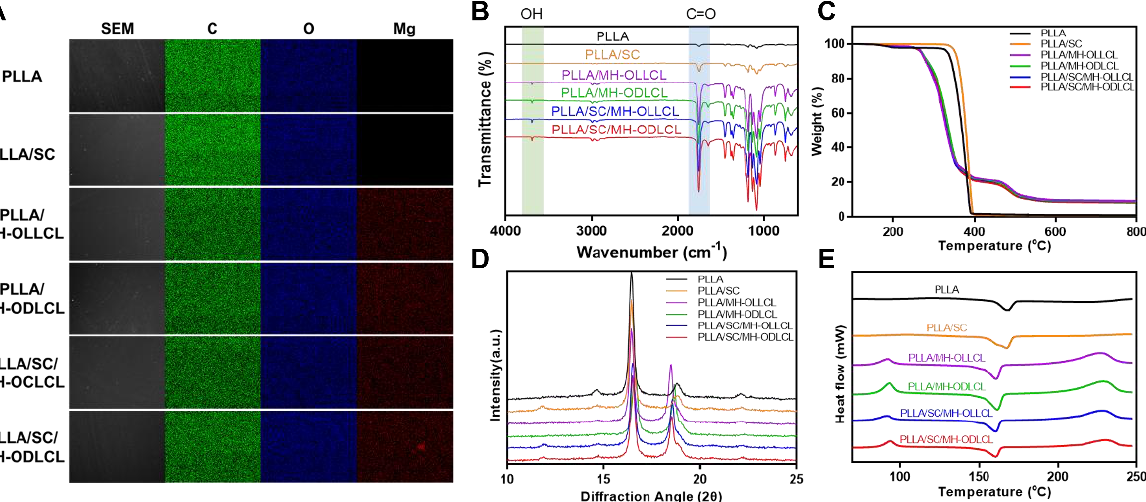
Table 2. Thermal properties of the PLLA, PLLA/SC, PLLA/MH − OLLCL, PLLA/MH − ODLCL, PLLA/SC/MH − OLLCL, and PLLA/SC/MH − ODLCL composites.